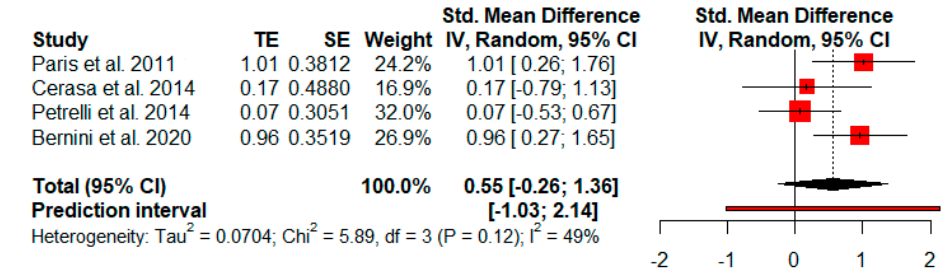
Figure 3. Effectiveness of cognitive rehabilitation in global cognitive Figure 3 . Effectiveness of cognitive rehabilitation in global cognitive status.